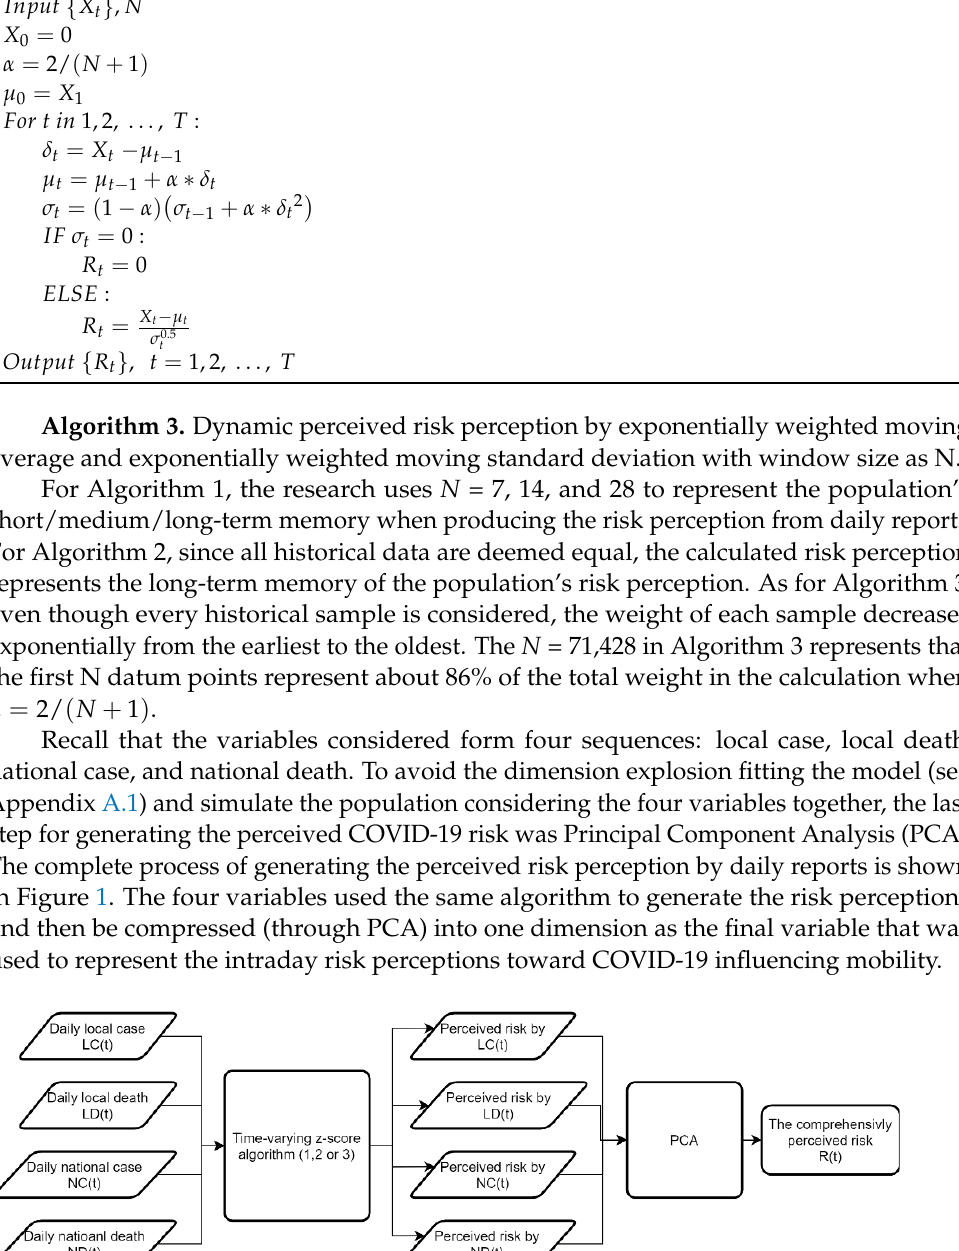
Algorithm 2. Dynamic perceived risk perception by moving average and moving standard deviation with all historical samples. Algorithm 3 Exponentially-weighted moving z-score with window size n(EMZ_n)